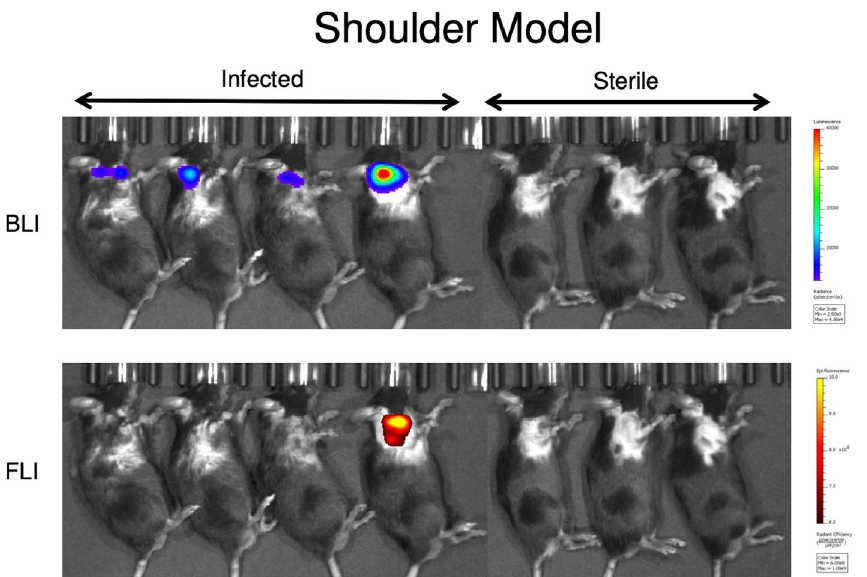
Figure 8. Bioluminescence and fluorescence imaging of mice with a spinal allograft infection 72 h post 1D9-680 probe injection. At 72 h PI of the 1D9-680 probe, co-localization of the probe in 1 out of 4 mice with infected shoulder arthroplasty is evidenced by bioluminescence and fluorescence imaging as described for Fig. 3. As expected, neither bioluminescence nor fluorescence are detectable in the 3 control mice with sterile shoulder